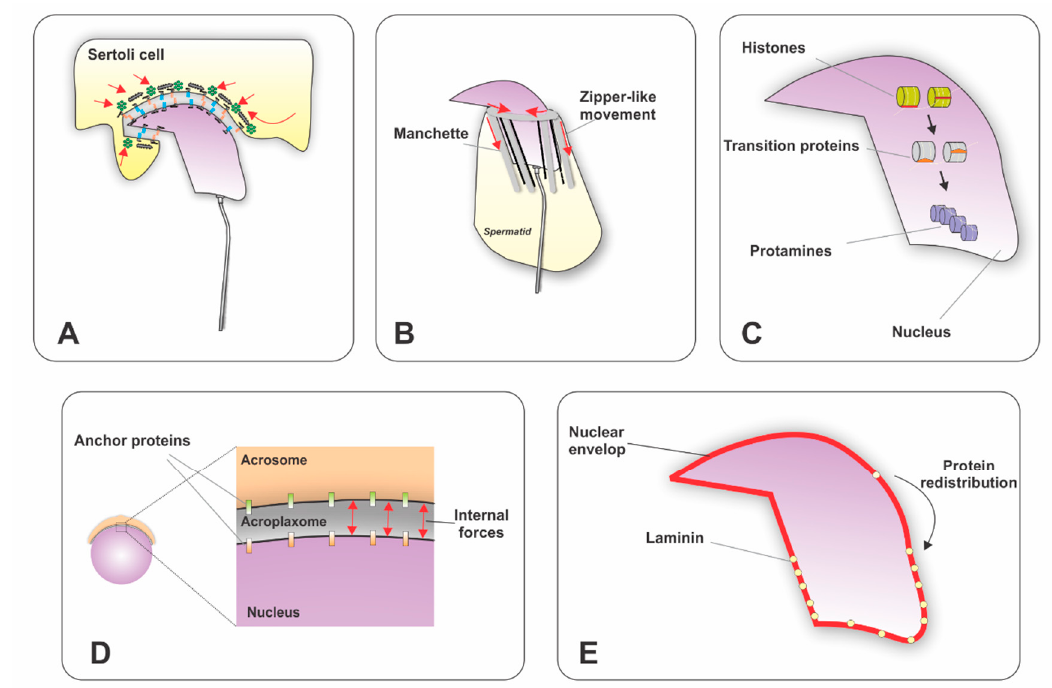
Figure 1. Schematic representation of the processes involved in remodeling of nuclear architecture during sperm differentiation. Illustrations represent mouse spermatids. ( A ) Sertoli cells influence nuclear remodeling by an ectoplasmic specialization that encircles more than one-third of the spermatid head and generates external pressure. ( B ) The manchette, a sca ff olding of microtubules and actin filaments, encircles two-thirds of the remaining area of the nucleus. It connects intimately with the nuclear lamina and generates internal forces by a zipper-like movement. ( C ) Replacement of histones by transition proteins and then protamines generates the last twists for chromatin condensation. ( D ) The acroplaxome, which covers more than one-third of the head, modulates the external forces and anchors the acrosome to the nucleus. Additionally, the ( E ) nuclear membrane restructures its molecular composition, redistributing proteins in order to adjust the flexibility of the membrane to allow for external and internal forces. Red arrows indicate the direction of